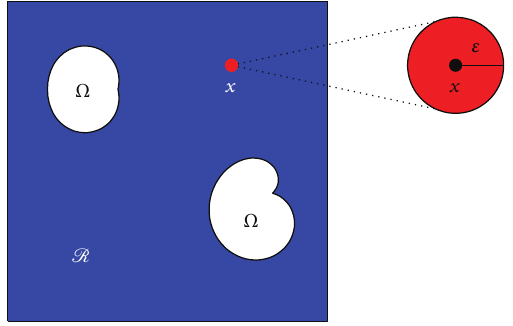
Figure 2: Geometry for the computation of topological